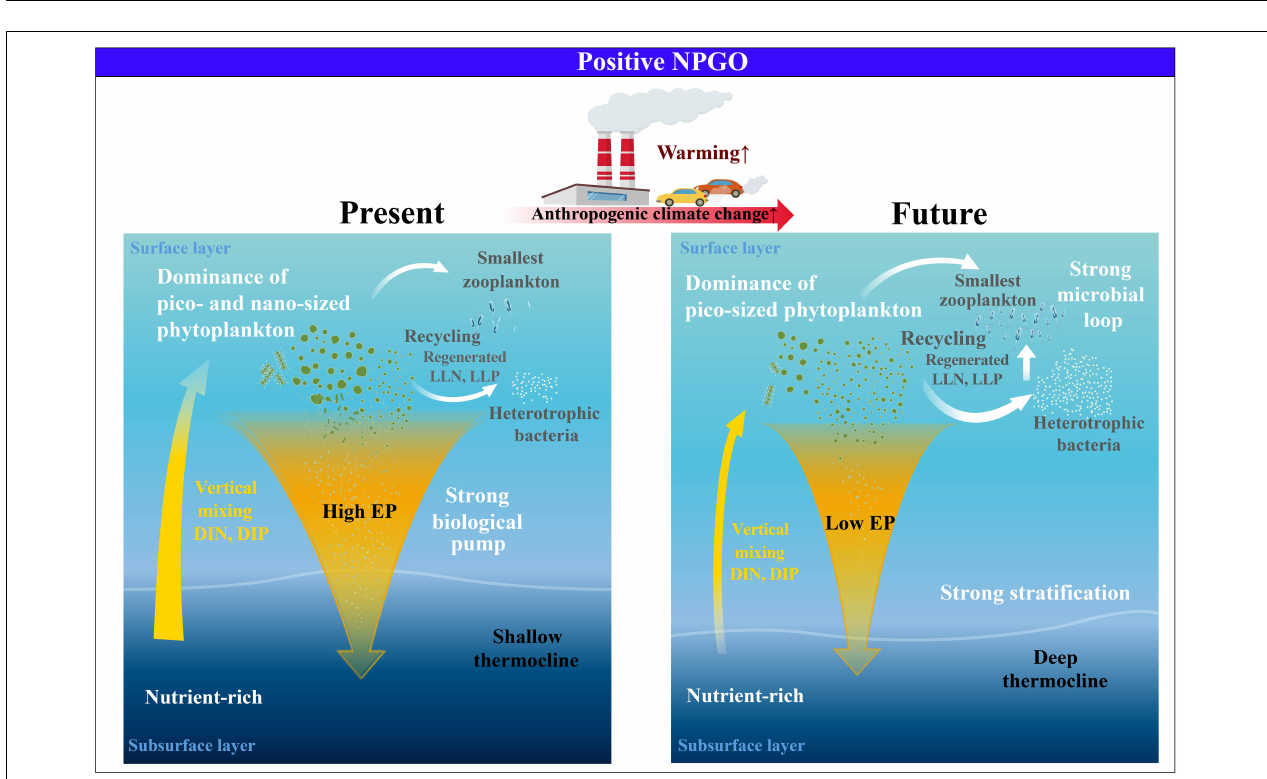
FIGURE 3 | smaller circles indicate monthly values; (C) DIN:DIP (blue larger circles) and PON 150 :POP 150 (brown larger squares) ratios, in which error bars indicate the STDs, dotted lines indicate linear trends (increasing trends during the N 2 + phase and decreasing trends during the N 4 + phase), and smaller markers indicate monthly values; (D) Heterotrophic bacteria cell abundances, in which the marker is same as that in panel (A) ; (E) LLN (orange bars) and LLP (green bars), in which error bars indicate the STDs, the study period average is shown in the corresponding color dotted line; and (F) The smallest-sized mesozooplankton biomass, in which the marker is same as that in panel (A) . STD, three standard deviations; PON 150 , particulate organic nitrogen flux; POP 150 , particulate organic phosphorus flux; DIN, dissolved inorganic nitrogen; DIP, dissolved inorganic phosphorus; LLN, low-level nitrate + nitrite; LLP, low-level phosphate.